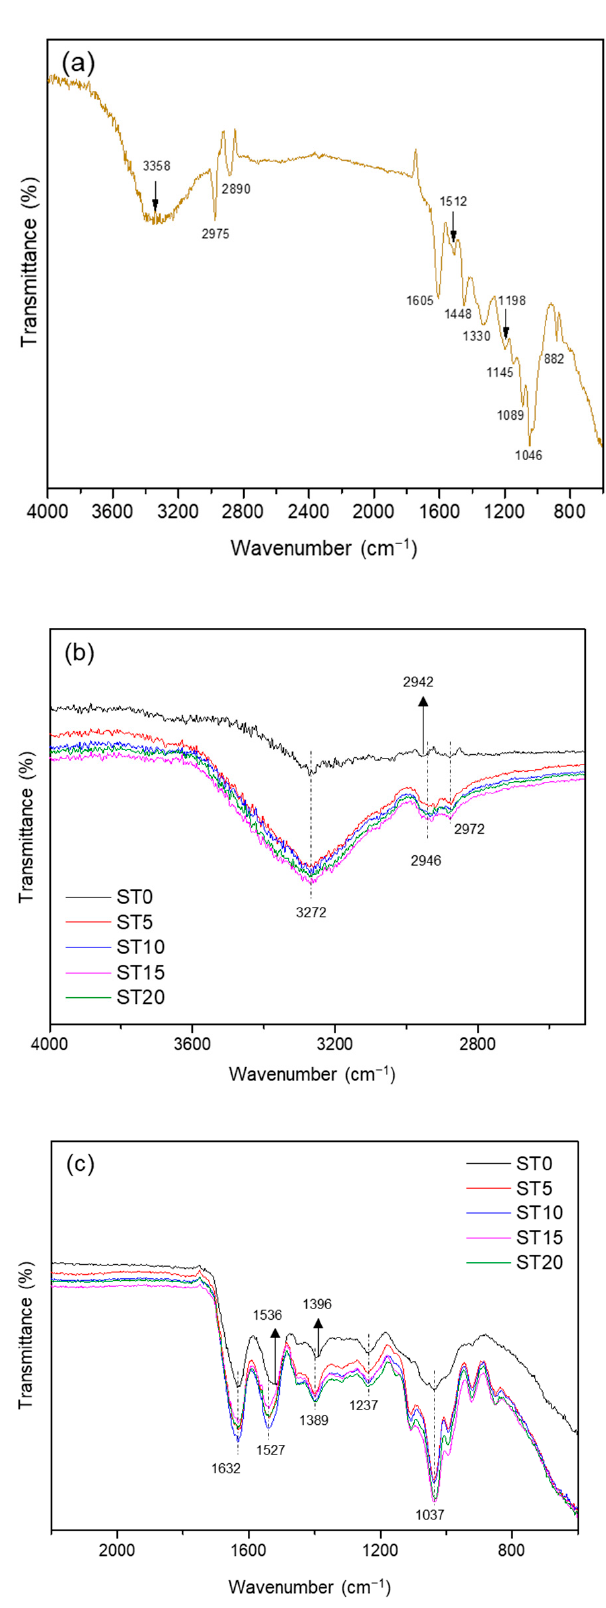
Figure 2. FTIR spectra of ( a ) BT and ( b , c ) SPI–BT